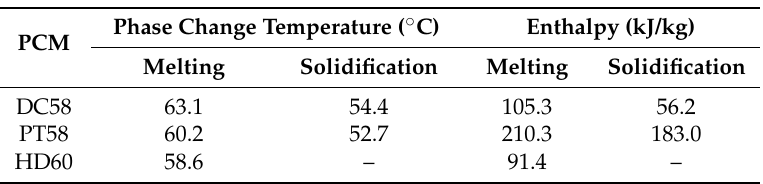
Table 6. Results from the TG-DSC analysis.